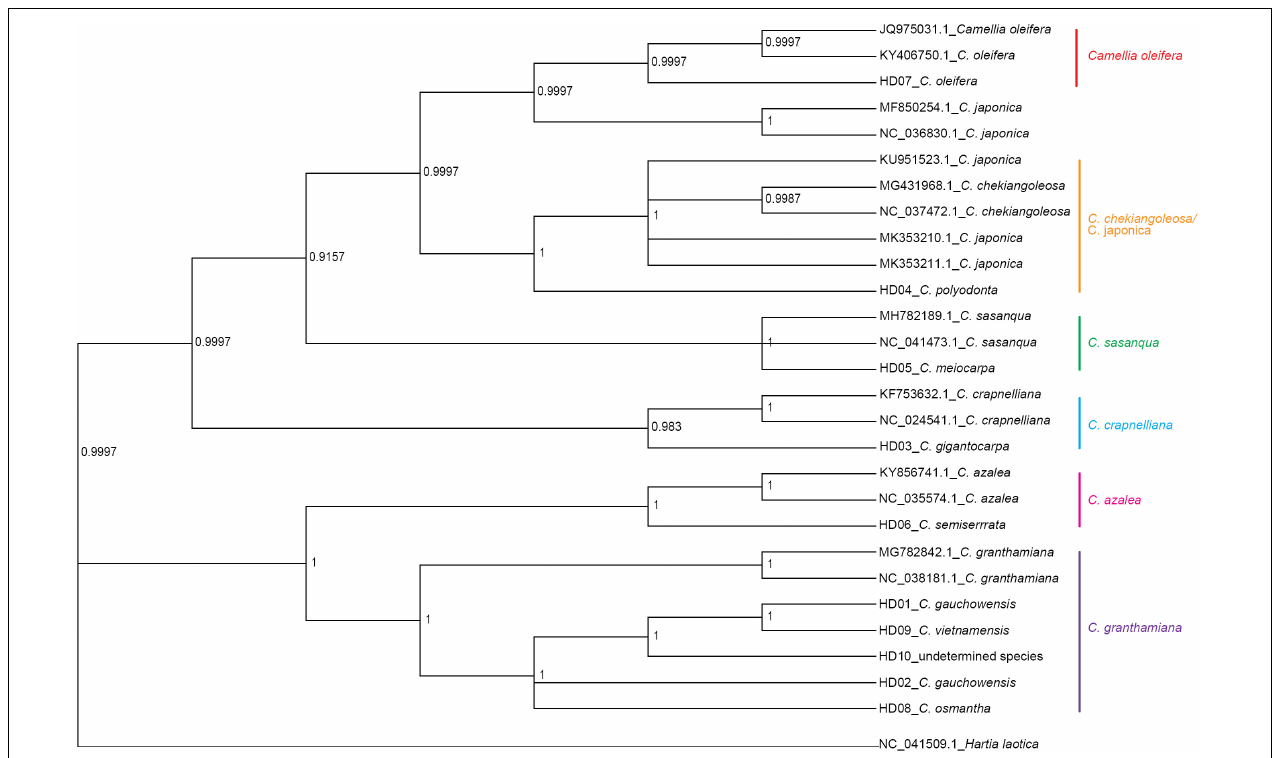
FIGURE 4 | Phylogenetic tree of 13 samples based on chloroplast genome (cpDNA) constructed using the Bayes inference method (BI).